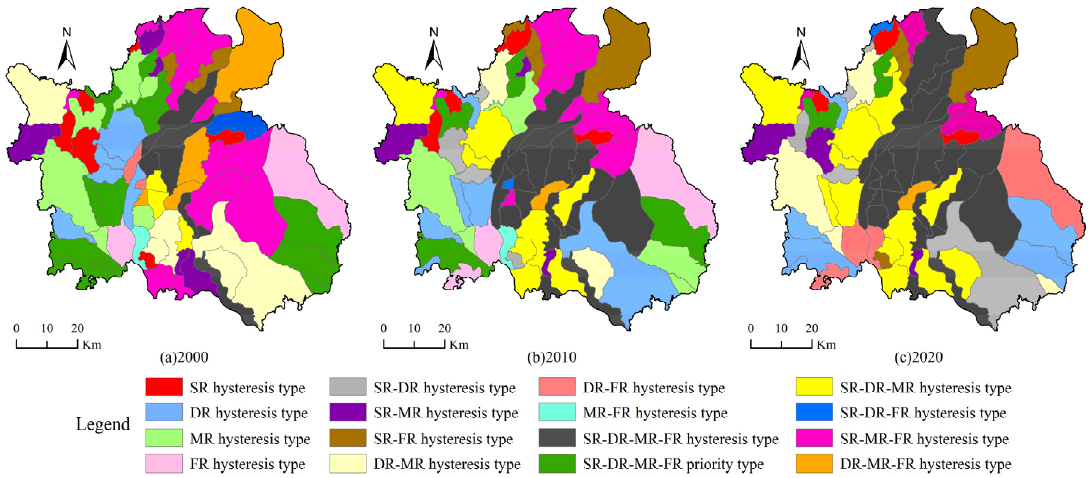
Figure 7. Combination of resilience subsystem in Nanchang City based on water network group. Note: SR, DR, MR, FR represent scale resilience, density resilience, morphology resilience, and functional resilience , respectively.